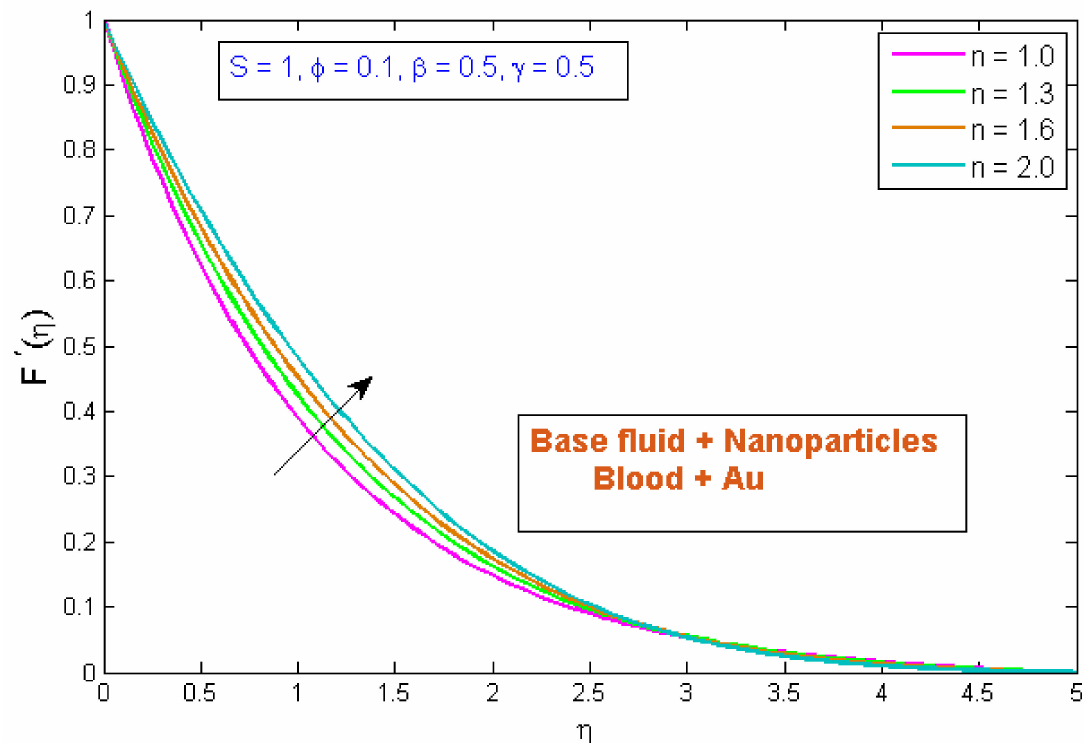
Figure 3. Modification of F (cid:48) ( η ) versus n